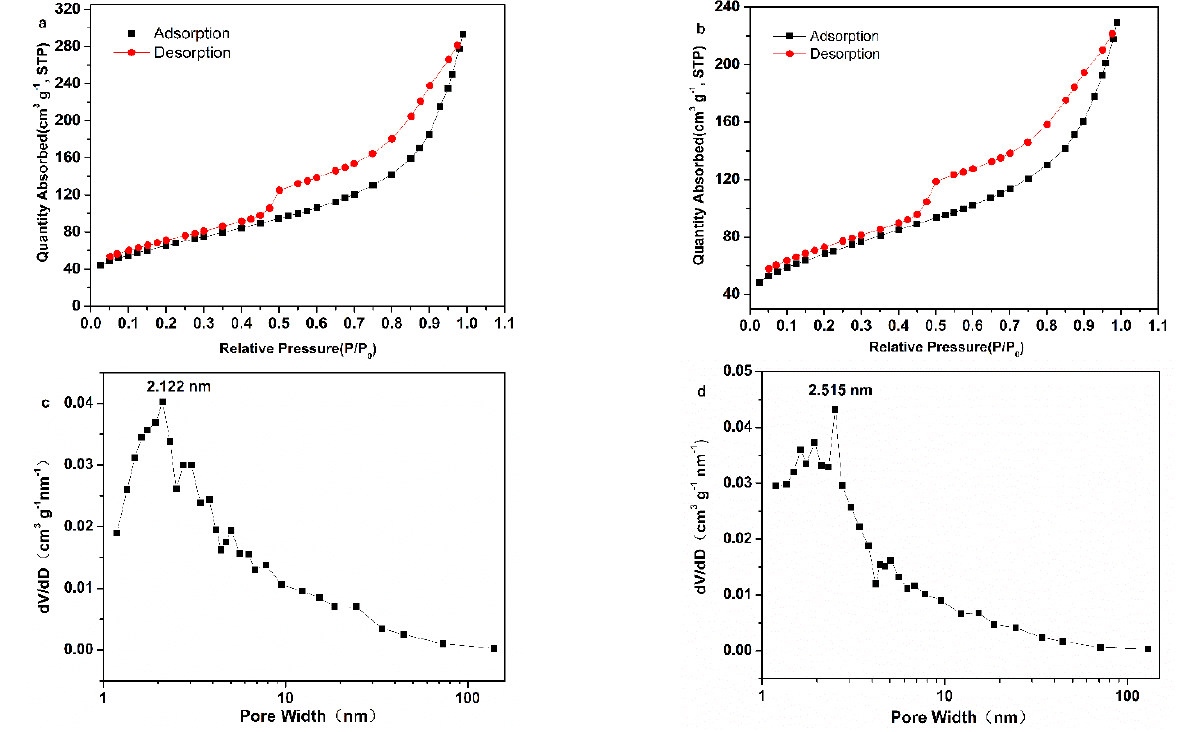
Figure 5. N 2 sorption isotherms of FeOOH-GA 0.25 ( a ) and FeOOH-GP ( b ), the pore size